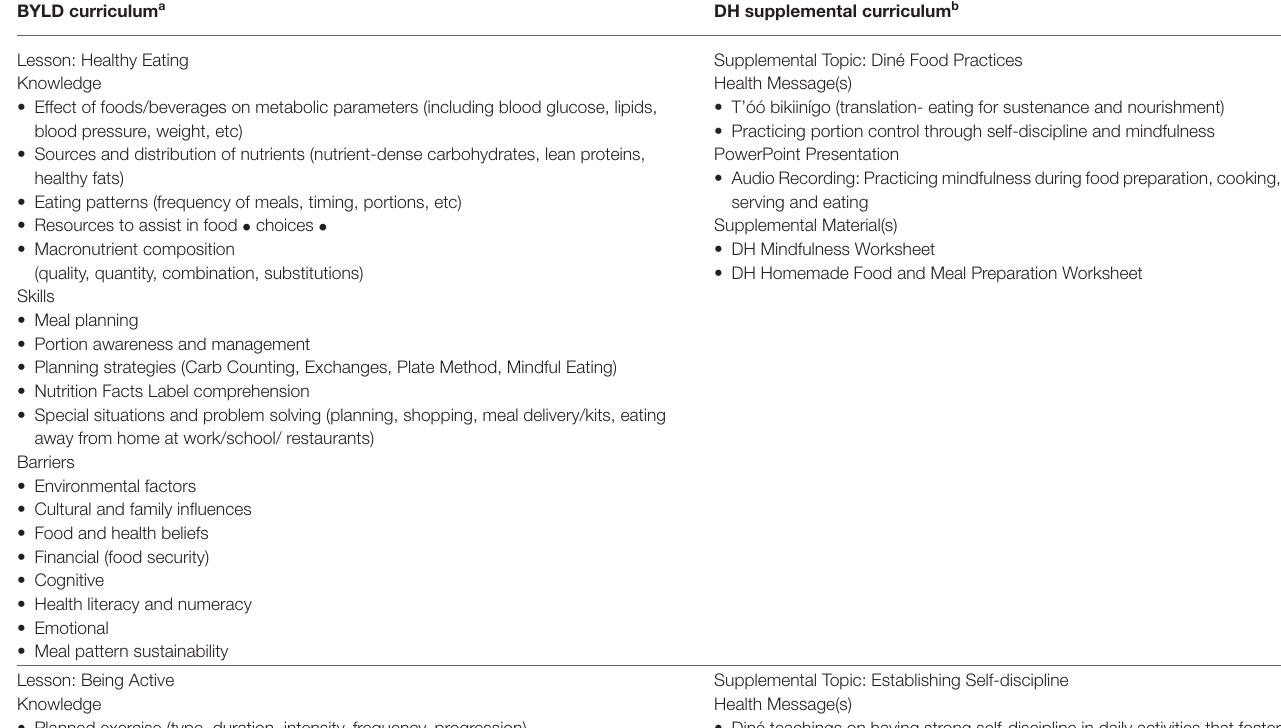
TABLE 3 | Balance your life with diabetes (BYLD) and Diné Health (DH) supplemental curriculum content. BYLD curriculum